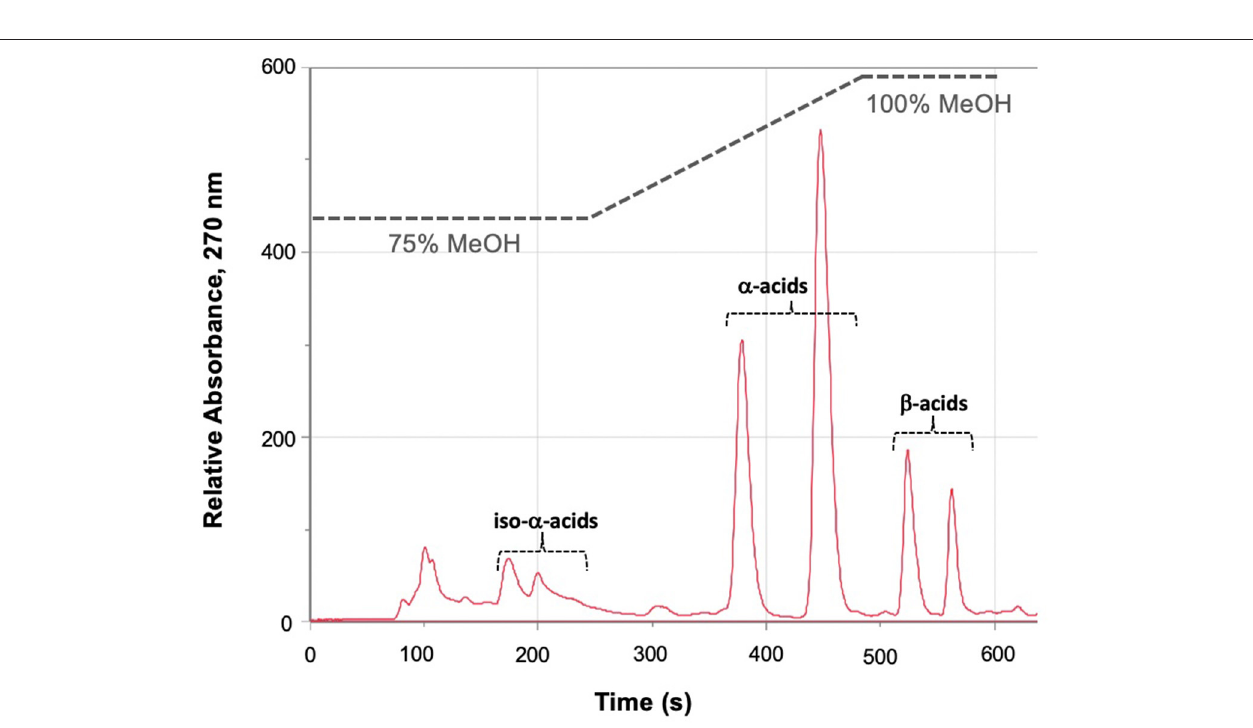
FIGURE 5 | Representative HPLC trace, A 270 , of the extract of spent yeast from a hoppy ale-style beer. Iso-alpha acids elute as a cluster between 180 and 210s; cohumulone elutes at ∼ 390s; humulone and adhumulone coelute at ∼ 450s; colupulone elutes at ∼ 520s; lupulone and adlupulone coelute at ∼